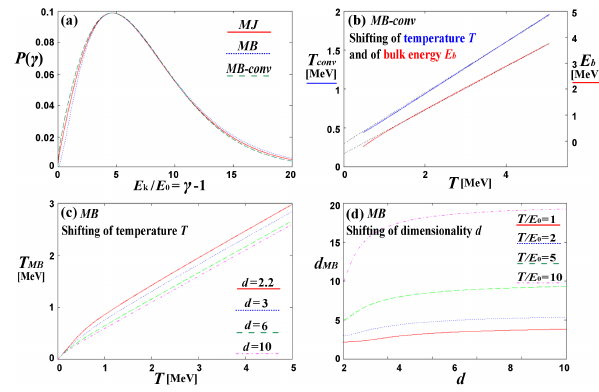
Figure 2. The plot of an MJ distribution of temperature T and de- grees of freedom d can be misinterpreted either by (i) a convected MB distribution, that is, with the same dimensionality, but with dif- ferent temperature T MB and bulk speed u b (or energy E b ≡ 1 or (ii) an MB distribution with the same bulk speed, but with differ- ent temperature T MB and degrees of freedom d MB . (a) A co-plot of an MJ distribution and the two mentioned MB distributions. (b) The temperature T MB and the bulk energy E b are plotted as functions of T . (c) The temperature T MB as a function of T , for various di- mensionalities, and (d) the dimensionality d MB as a function of the dimensionality d and various